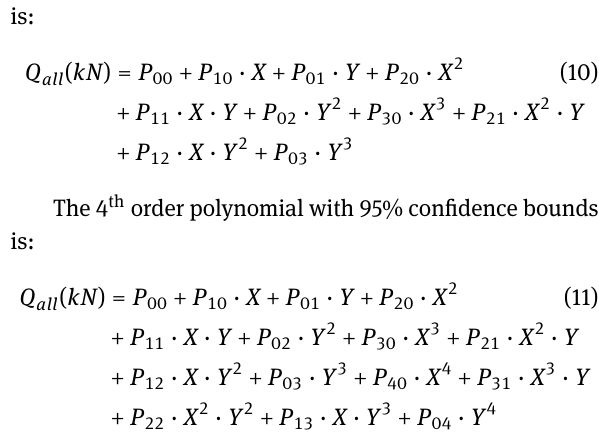
Figure 5: Variation the allowable bearing capacity of driven pile (6 m